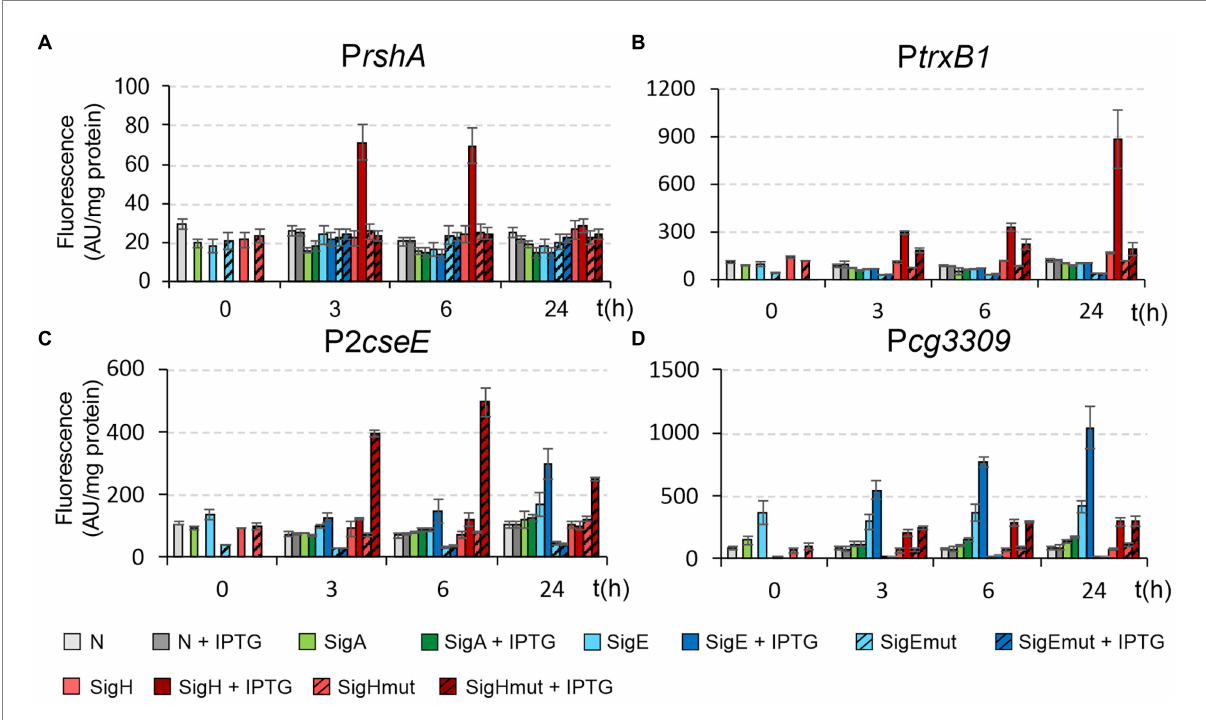
FIGURE 11 Activity of σ H -controlled promoters P rshA (A) and P trxB1 (B) and σ H / σ E -controlled promoters P2 cseE (C) and P cg3309 (D) with wild-type and mutant σ H and σ E . The activities were determined by two-plasmid assay. The C. glutamicum strains carried the pEC-XT99A constructs overexpressing sigA , sigE , sigE mut, sigH, or sigE mut after IPTG addition (at time point 0) and the promoter-test vector pEPR1 carrying the reporter gfp uv gene downstream of the tested promoters. The strains carrying pEPR1 with the tested promoters and empty pEC-XT99A were used as the controls (gray bars). The fluorescence intensity of cultures without IPTG is shown as light bars; the fluorescence intensity of cultures with IPTG induction is shown as dark bars. AU, arbitrary units. The standard deviations of three biological replicates are depicted as error